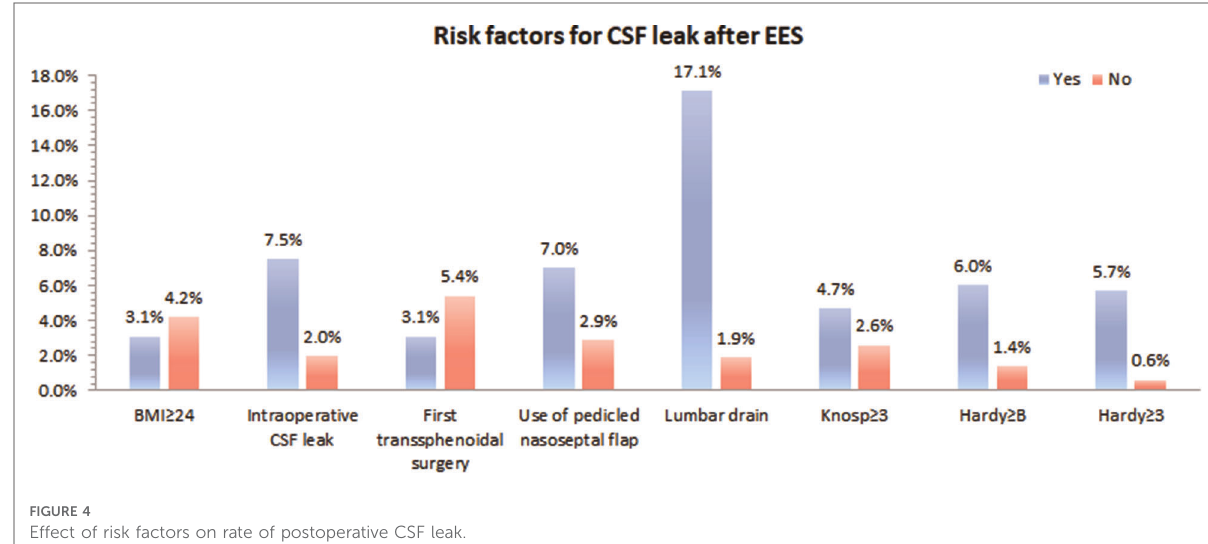
FIGURE 4 Effect of risk factors on rate of postoperative CSF leak.